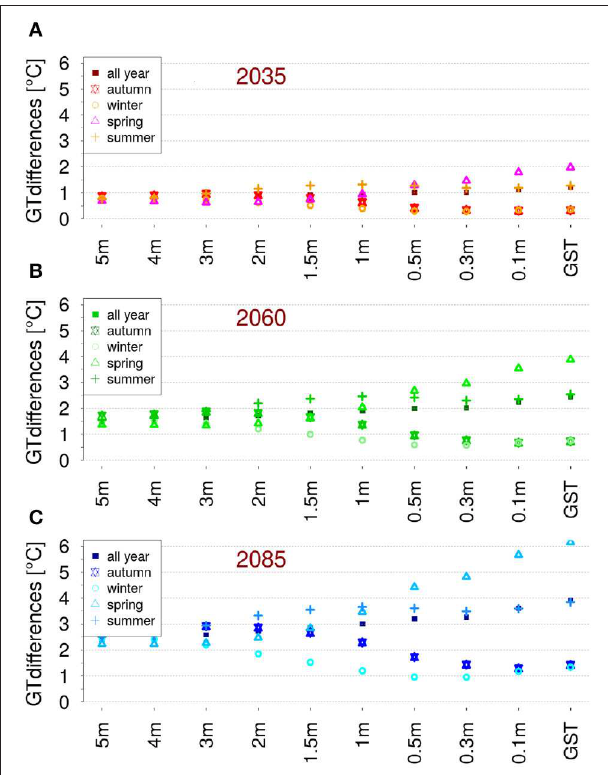
FIGURE 7 | Mean increase of ground temperature (GT) for snow accumulation period [November–January, (Autumn, star)], snow covered time [February–April, (Winter, circle)], melt out [May–July, (Spring, triangle)], and snow free period [August–October, (summer, cross)], and all year (square) for different depths. Dots represent the mean values of all 16 stations. Differences for 2035 (A) , 2060 (B) and 2085 (C)